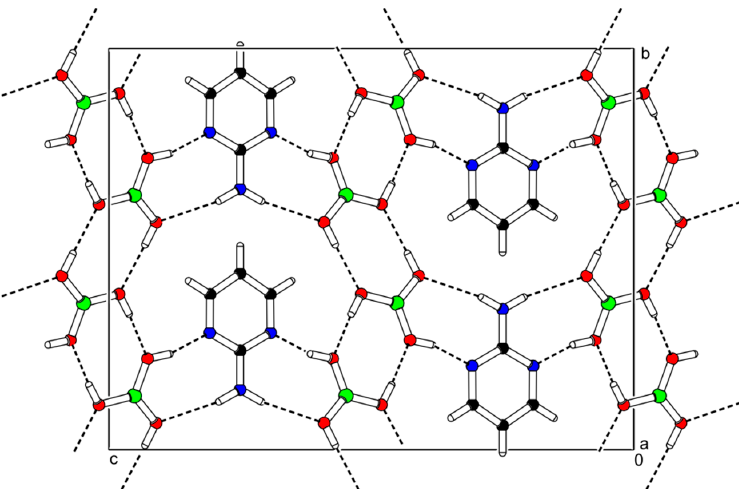
Figure 4. ORTEP plot of the asymmetric unit of 2-AMP(H 3 BO 3 ) 2 with atom numbering . The displacement parameters are shown at the 50% probability level.